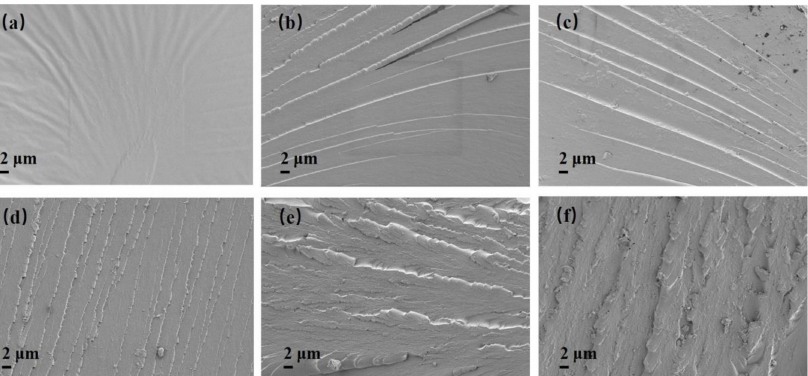
Figure 5. Scanning electron microscopy (SEM) images of tensile fracture surfaces for samples 3D- printed using BDM inks ( a ) BDM-1, ( b ) BDM-2, ( c ) BDM-3, ( d ) BDM-4, ( e ) BDM-5, and ( f )